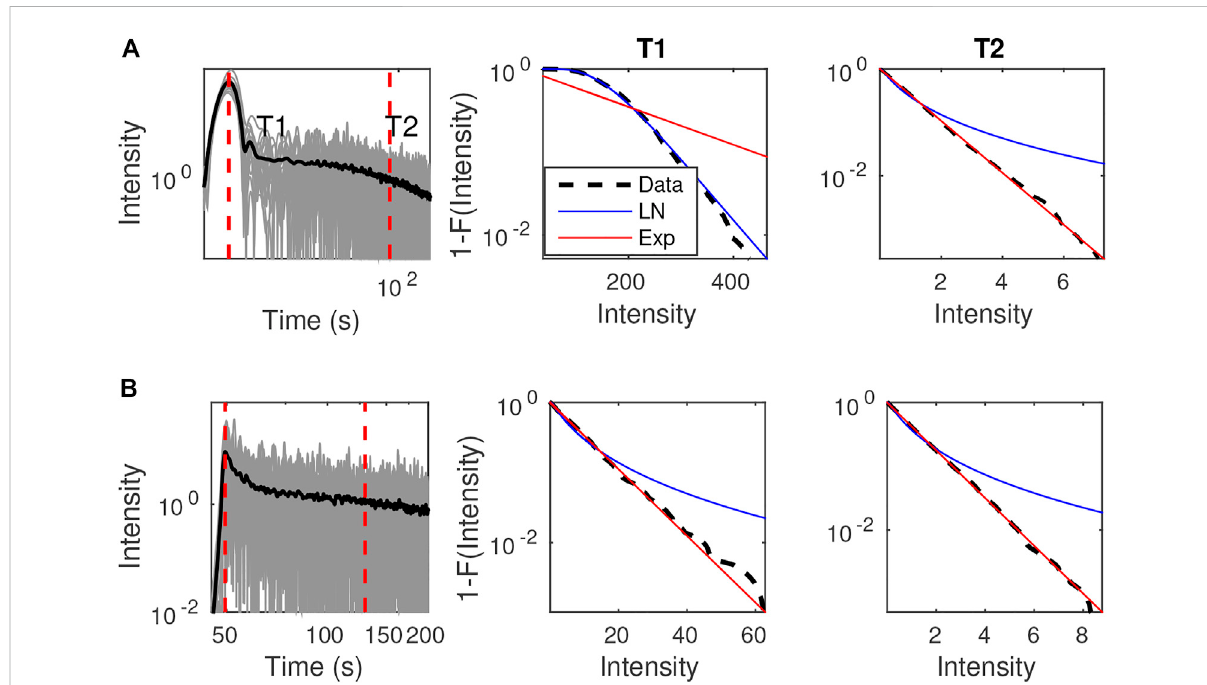
FIGURE 10 Distribution of intensities at distances (A) 5 km and (B) 150 km from the source for the case ] = 0.5, ε = 5% in the [1 , 2] Hz frequency band (Left) Ensemble of 180 realizations of SEM intensities (grey lines) and their mean value (black line); (Center and Right): Complement of the CDFs of intensities around lapse times T1 and T2 corresponding to the ballistic peak and the late coda (as indicated by the dashed red lines in the left panels). The solid blue and red lines show the fi tted Log-normal and exponential CDF. The black dashed line represents the empirical complementary CDF from SEM simulations.